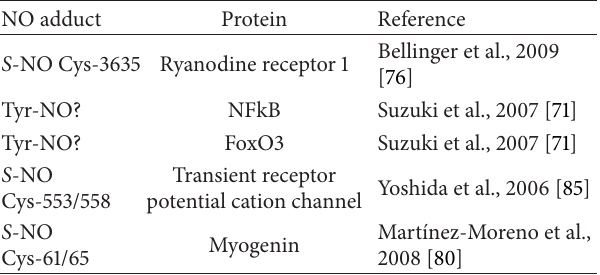
Table 2: Role and targets of NO in neuromuscular